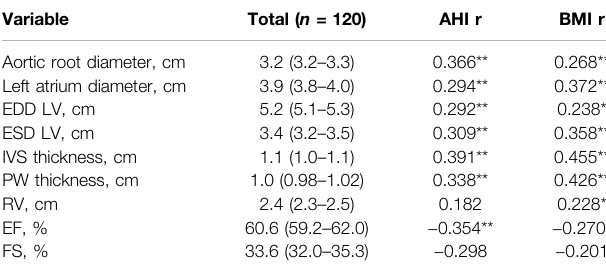
TABLE 5 | Echocardiographic parameters of the study population and their correlation with AHI and